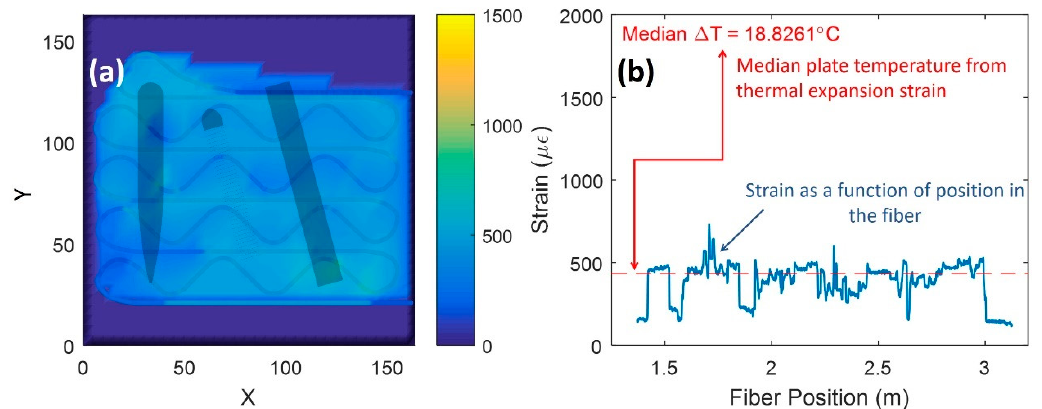
Figure 7. Spatial mapping of fiber data: ( a ) spatial map of fiber data with superimposed parts; ( b ) raw fiber data showing strain accumulation from heat generation from laser at layer 58.